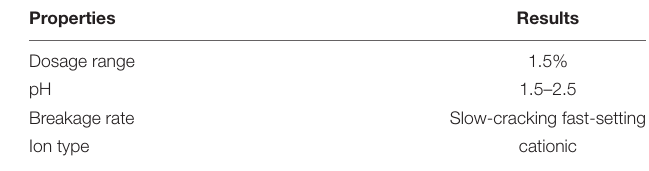
TABLE 2 | Basic properties of the